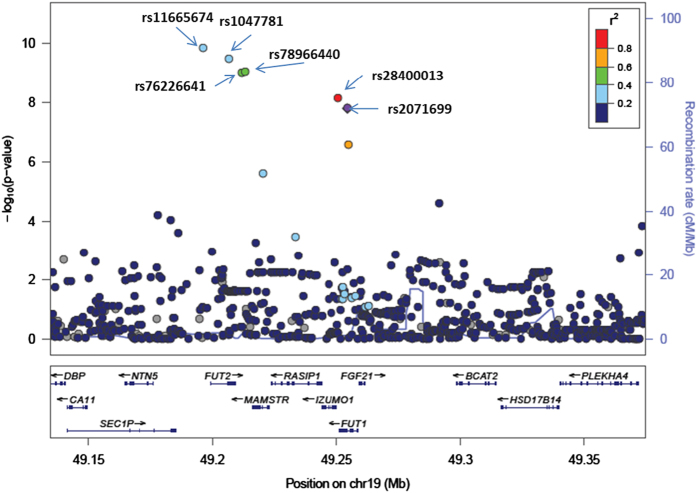
Regional association plot for imputed single-nucleotide polymorphism–alkaline phosphatase associations in the regions around and within the FUT1 and FUT2 loci. The P values of the imputed genotypes of the single-nucleotide polymorphisms in association analysis with serum alkaline phosphatase levels are plotted (as −log10 values) against their physical locations on chromosome 19. The estimated recombination rates in the Asian population of the 1000 Genomes Project (March 2012 release) show the local linkage disequilibrium structure. Each significant single-nucleotide polymorphism (P value<5×10−8) is indicated by an arrow. Inset: colors of other single-nucleotide polymorphisms indicate linkage disequilibrium with rs2071699 according to a scale from r2=0 to 1 based on pairwise r2 values from 1000 Genomes Project.